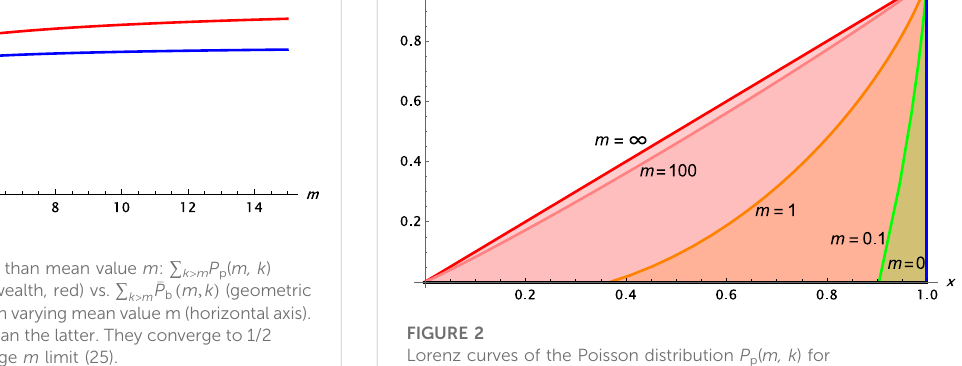
FIGURE 2 Lorenz curves of the Poisson distribution P p ( m, k ) for distinguishable wealth. i) m = ∞ , G p (cid:2) 0 (45-degree line of perfect equality), ii) m = 100, G p ≃ 0 . 056, iii) m = 1, G p ≃ 0 . 52, iv) m =